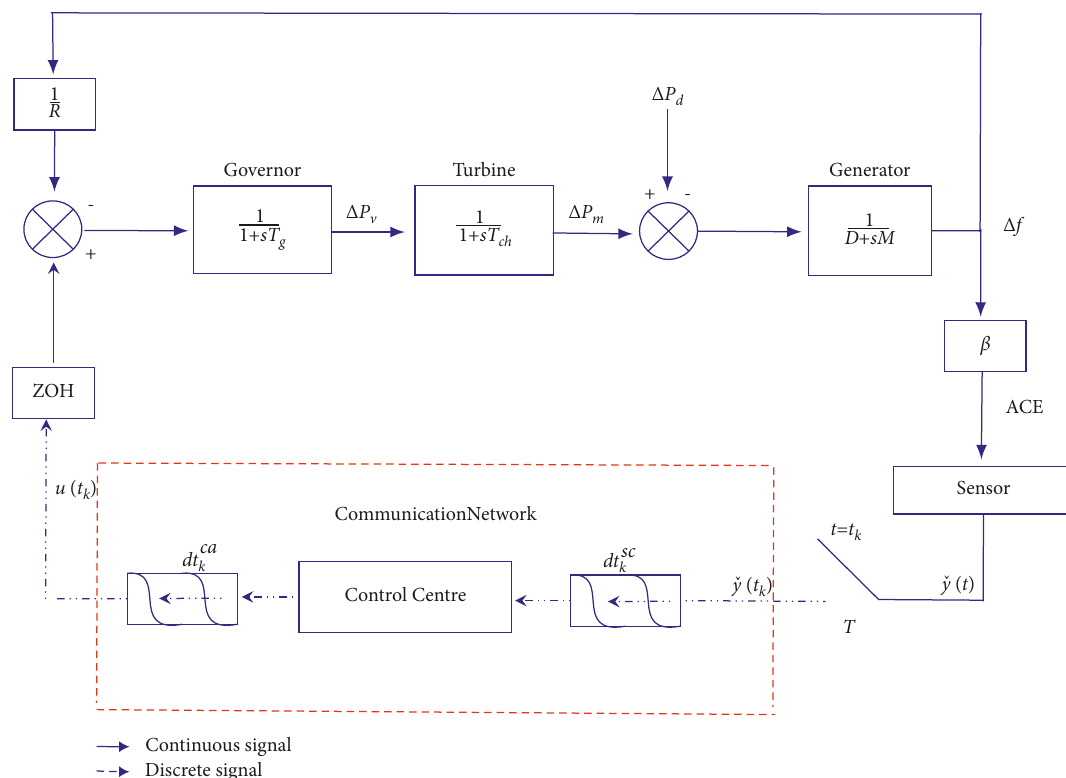
Figure 2: Dynamic model of one-area LFC scheme over the communication network and the transmission delay from